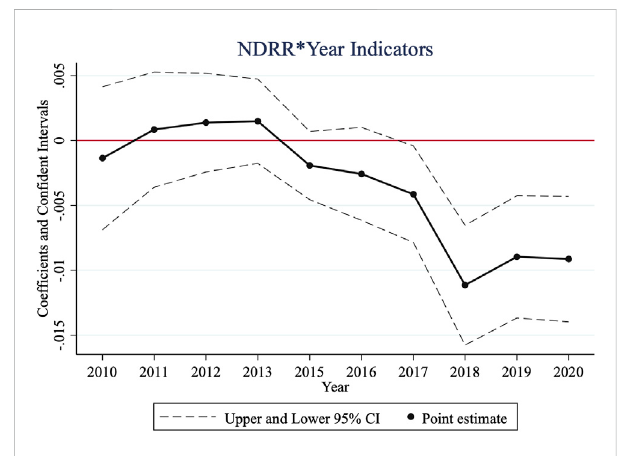
FIGURE 3 Flexible estimates of the relationship between NDRR and